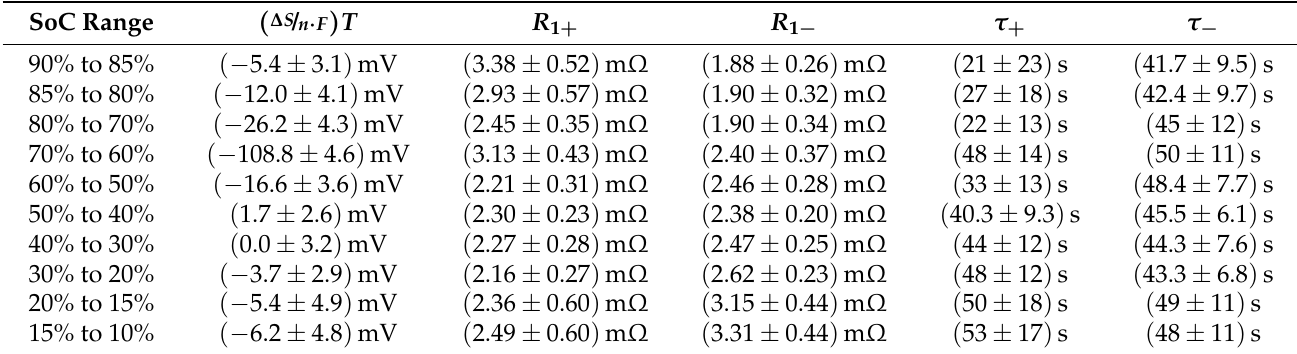
Figure 5. Total amount of heat generated at various current amplitudes with the SoC changing from 60% to 70% for positive currents and vice versa for negative currents. Table 3. Fitted coefficients including the 95% confidence